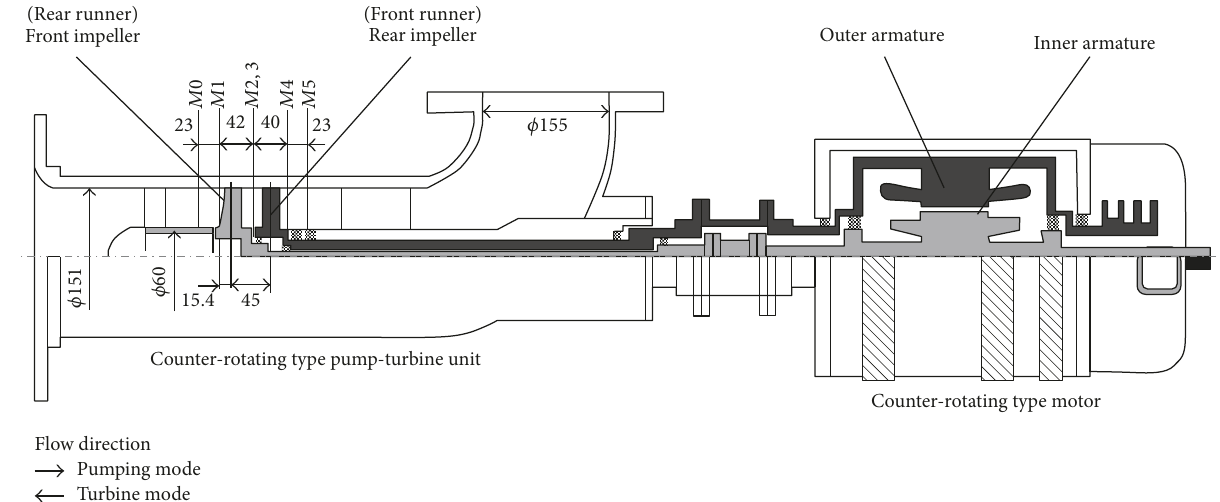
Figure 1: Counter-rotating-type pump-turbine unit